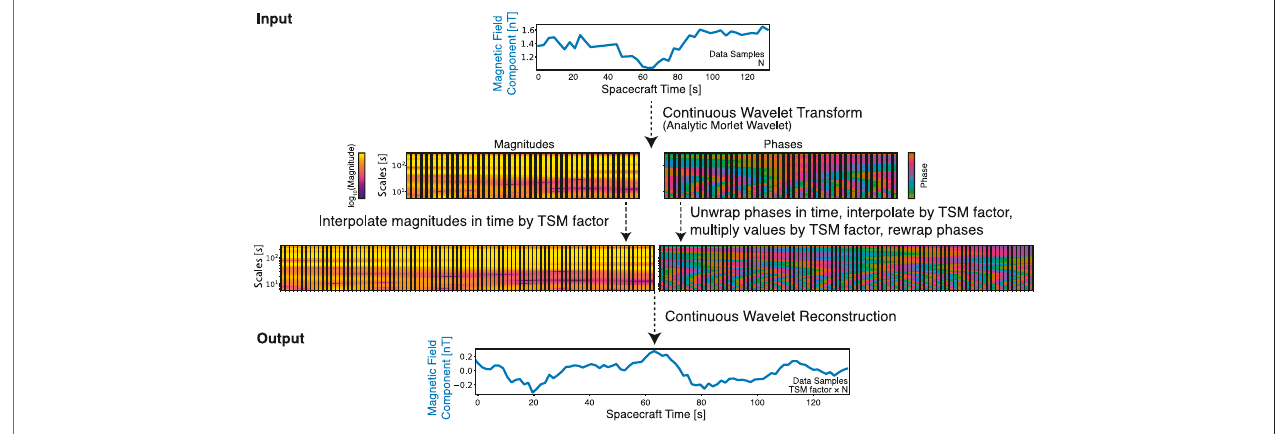
FIGURE 6 | Illustration of the Wavelet phase vocoder method. Note the shorter time range presented due to the different